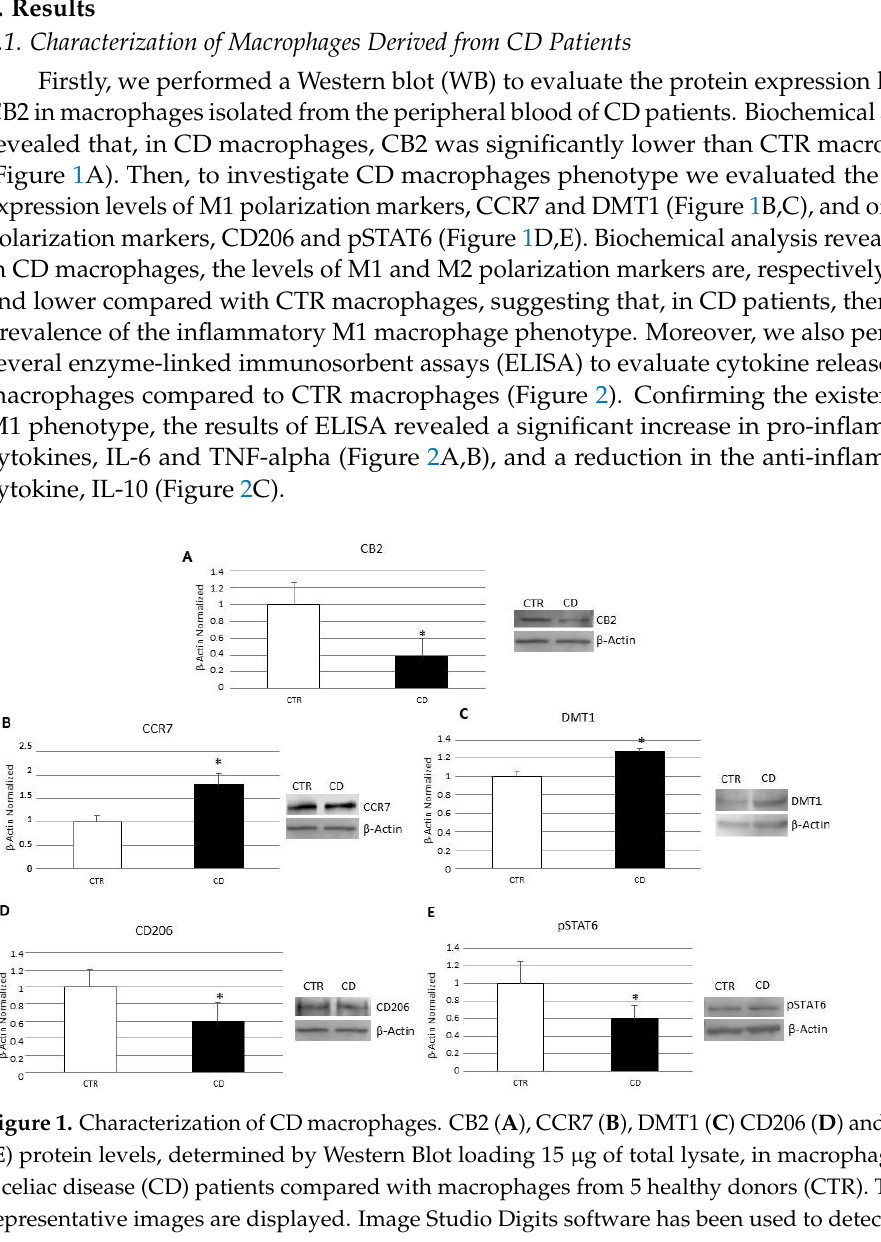
Figure 2. Cytokines concentration evaluation in CD macrophages. IL-6 ( A ), TNF-alpha ( B ) and IL- 10 ( C ) concentrations (pg/mL) in macrophages from 5 CD patients compared with macrophages